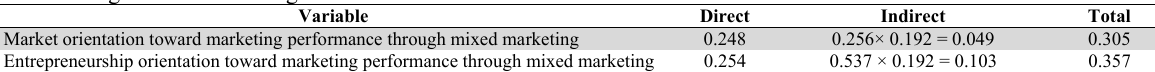
SEM Test Results for the Sixth Hypothesis. Market orientation and entrepreneurship orientation towards marketing perfor- mance through mixed